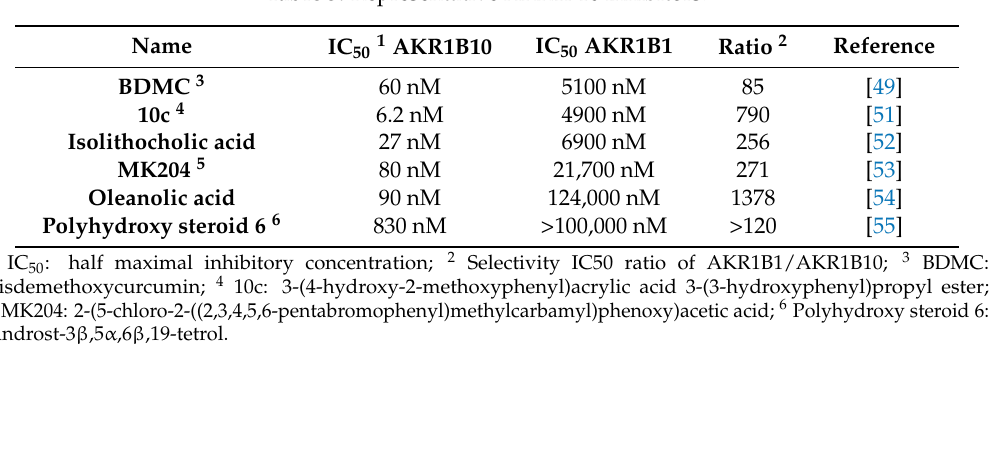
Table 3. Representative AKR1B10